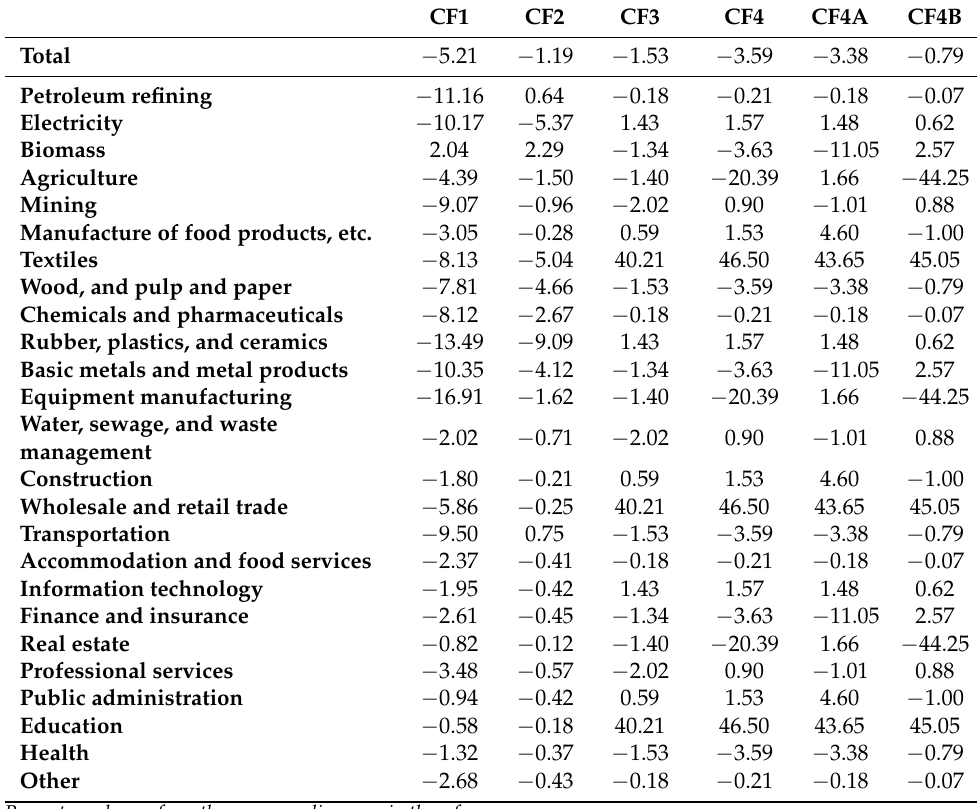
Table 7. Long run [2030] effects: output by industry.